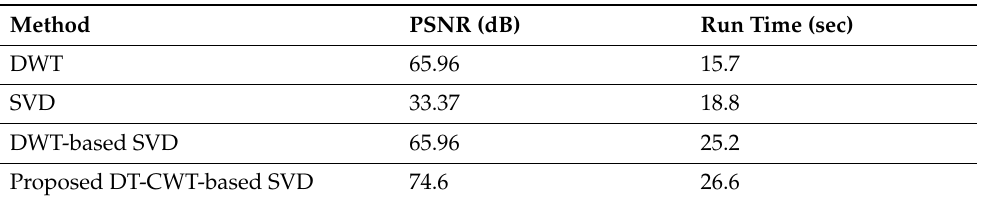
Table 6. Comparison between the proposed watermarking method and the traditional methods without attacks.